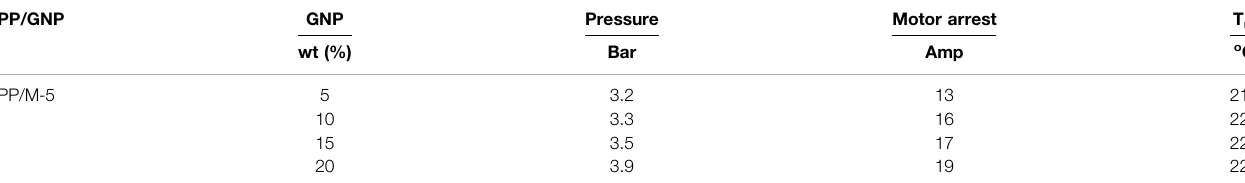
TABLE 2 | Process parameters set for PP/GNP twin-screw